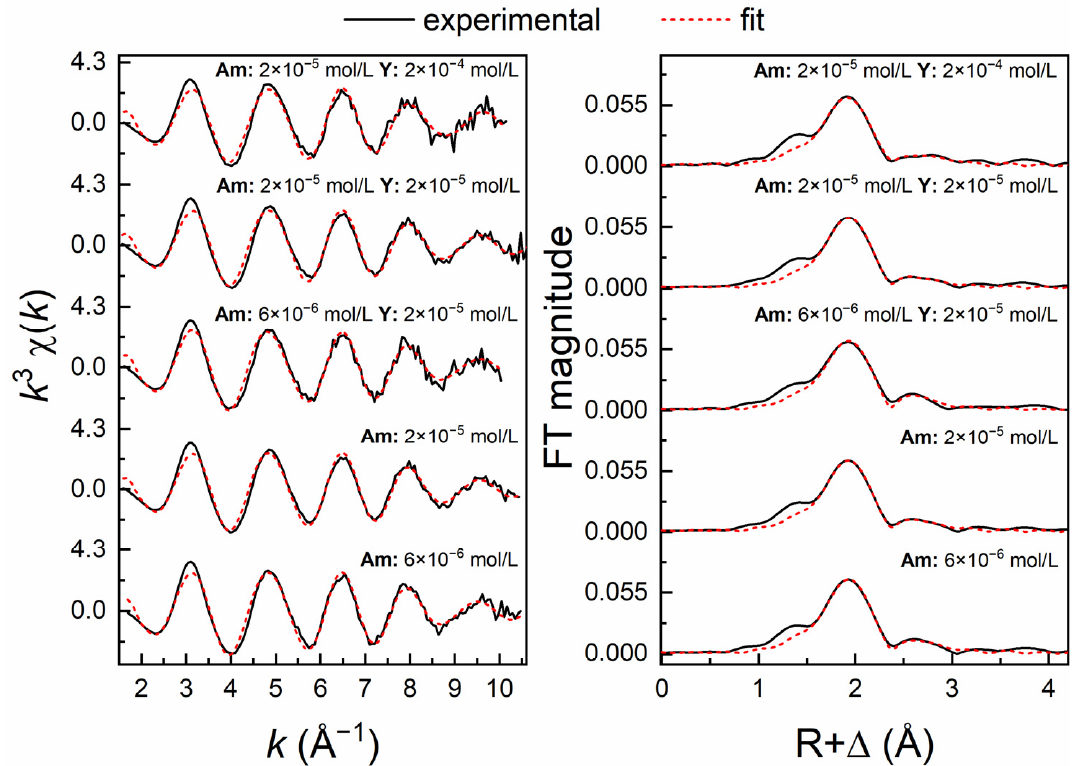
Figure 4. k 3 -weighted Am L III -edge EXAFS spectra ( left ) and corresponding Fourier transforms ( right ) of corundum samples containing Am 3+ in the absence and presence of Y 3+ at pH ~8.5. Solid lines; experimental data, dashed lines; theoretical fitting. Phase shifts ( Δ ) are not corrected in the FTs. Table 4. Structural parameters derived from the k 3 -weighted EXAFS spectra for the Am L III edge. EXAFS fitting was performed over the k range of 1.6–10.5 Å − 1 using a constant amplitude reduction factor (S 02 ) of 0.9. CN: coordination number, R: radial distance, σ 2 : Debye–Waller factor, R % : fitting residual. Values in parenthesis are the calculated confidence limits of the fitted parameters. The conservative common absolute error in EXAFS shell fit is CN ± 20%, R ± 0.02 Å [66]. Sample Composition